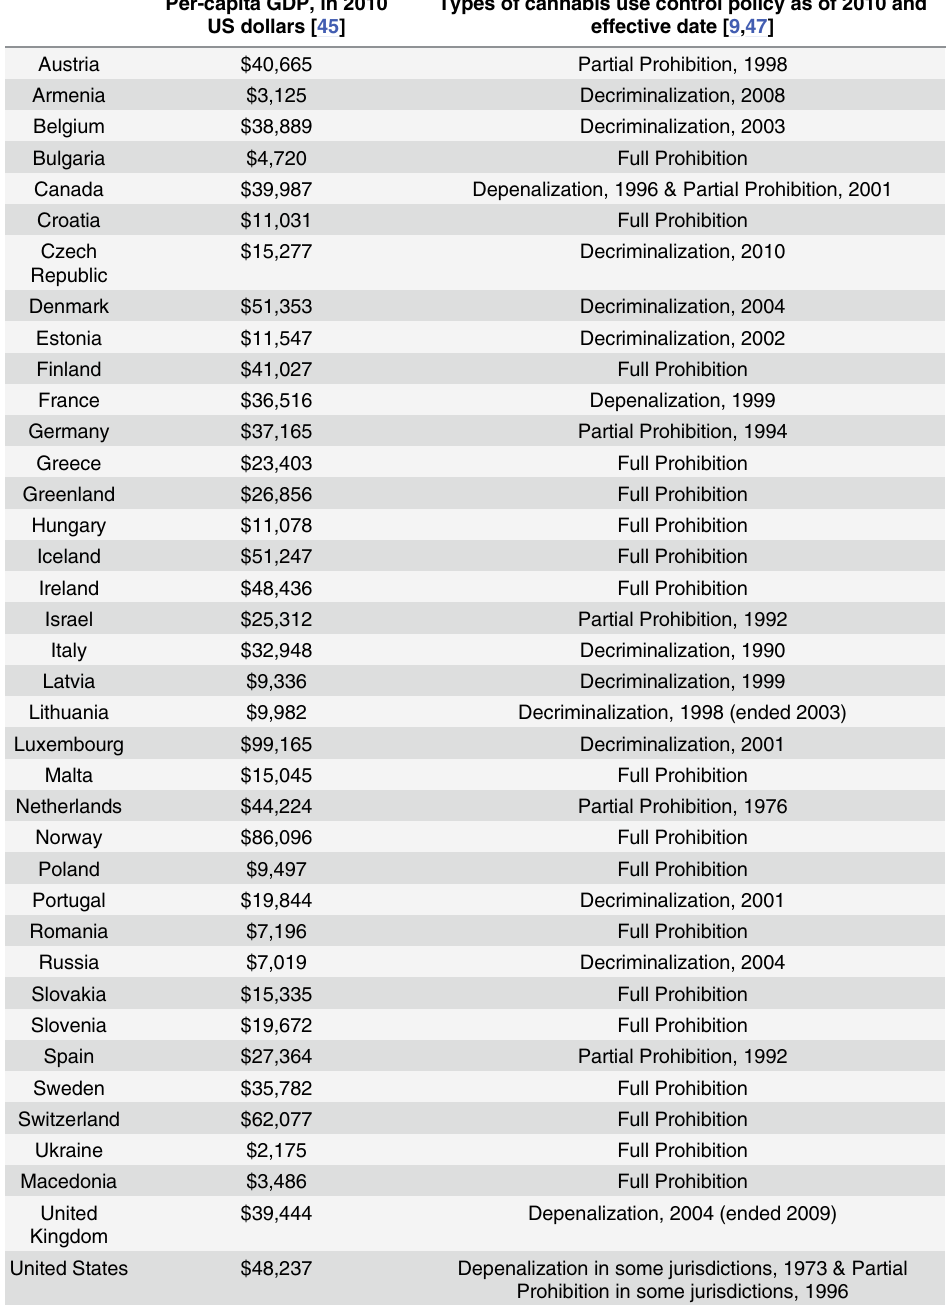
Table 2. Summary of country-level variables. Per-capita GDP, in 2010 Types of cannabis use control policy as of 2010 and US dollars [45] effective date